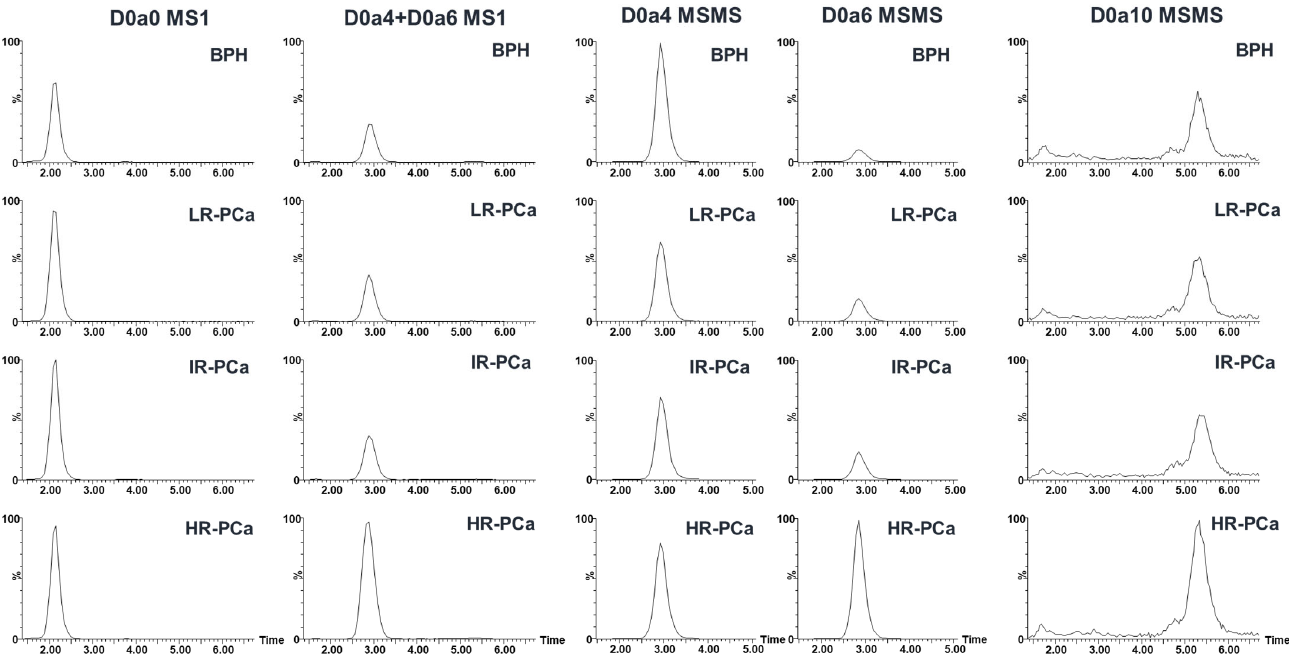
Figure A1. Representative extracted ion chromatograms of CS disaccharide measurements. See Figure 1 for resolving the GAG structure codes.